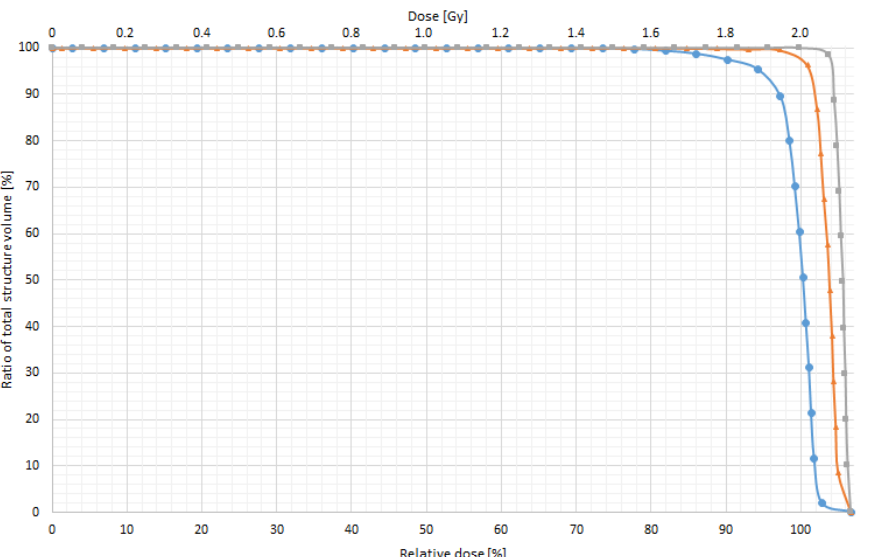
Figure 10. Dose volume histograms for three IMRT plans obtained for the patient-specific phantom: without bolus (blue), with 0.5 cm 3D bolus (red) and 1.0 cm 3D bolus